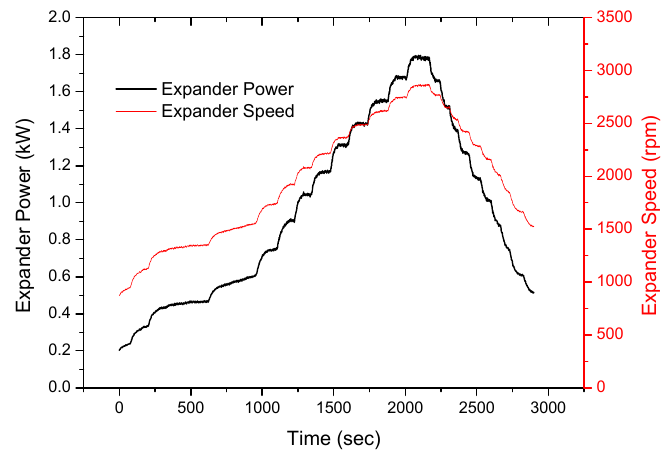
Figure 7. Expander speed and power.